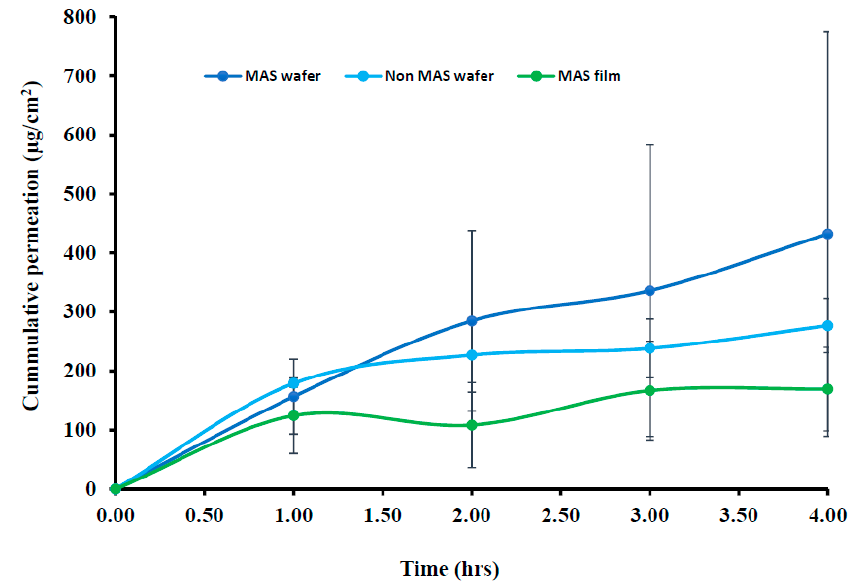
Figure 8. Cumulative permeation curve of wafers and films using porcine buccal tissue ( n = 3, ± SD). Table 5. Permeation flux ( J ) for NIC from optimized wafers and films through porcine mucosa The highest cumulative permeation and permeation flux ( J ) was shown in MAS wafers with the membrane and EpiOral TM tissue maximum cumulative permeation of 432.30 ± 343.04 μ g/cm 2 within 4 h and permeation flux ( J ) of 108.08 ± 85.76 μ g/cm 2 /h, while the lowest cumulative permeation and permeation flux ( J ) was shown in MAS films with the maximum cumulative permeation of 169.30 ± 70.67 μ g/cm 2 within 4 h and permeation flux ( J ) of 42.33 ± 17.67 μ g/cm 2 /h.